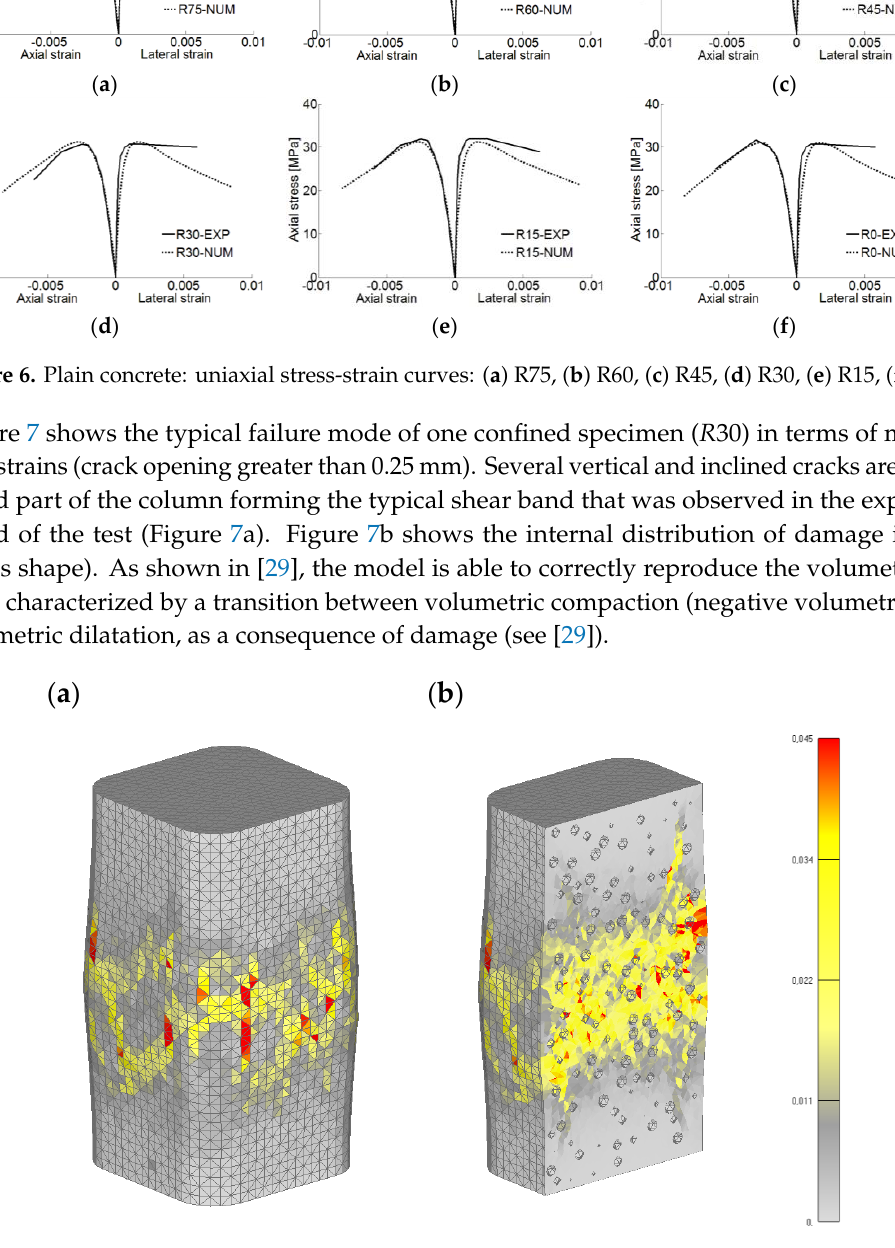
( d ) Figure 5. FE model for R 60: ( a , b ) concrete ( c , d ) CFRP. 4. Results and Discussion The results of the numerical simulations are presented in this section for both unconfined and CFRP-confined specimens. First, the results obtained with the simplified meso-scale model